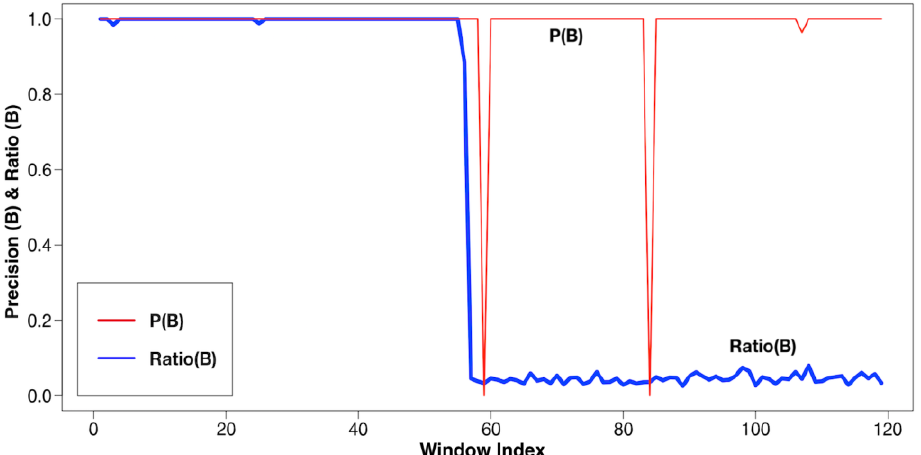
Figure 12. Correlation between precision (B) and intensive attacks demonstrated in the drastically fluctuating